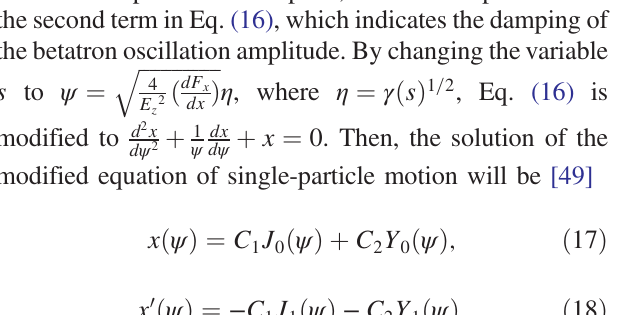
FIG. 19. Electron-beam projections (a – e) and slice distributions (f – j) before entering the plasma source obtained by ELEGANT simulation. (a, f) are for the reference case without CSR effect, (b, g) are for the case in which the CSR effect is fully suppressed so that the emittance growth is nearly 0%, and (c, h) are for the case in which the CSR effect is not suppressed, resulting in the emittance growth of 11%. Also, (d, i) are the case where the CSR- induced emittance growth is 21%, and (e, j) are the case where the emittance growth is 32%. The beam head is located at negative t , while the beam tail is placed at positive t .